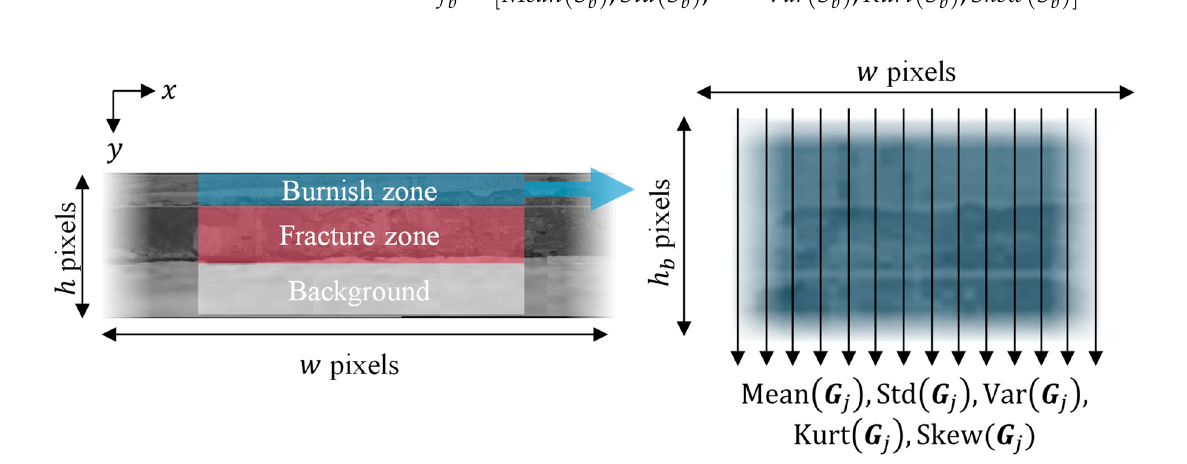
Figure 11. Extraction of statistical features of panoramic images.